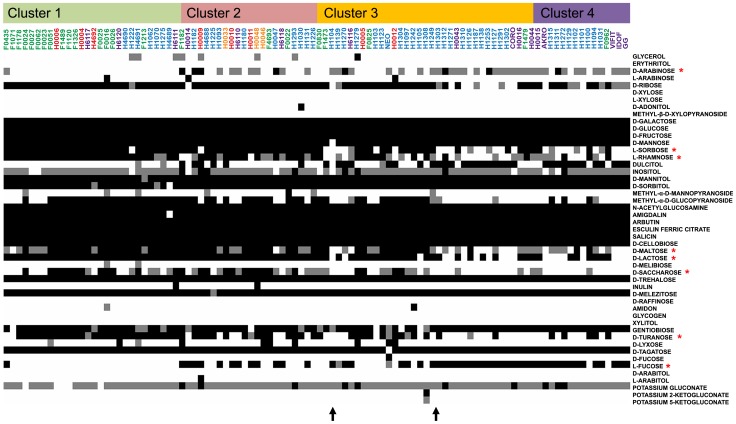
API 50CH fermentative profile of L. rhamnosus strains.Fermentation ability is indicated in black for positive, grey for partially positive and white for negative. Strains are organized according to their genetic relatedness as defined in the hierarchical clustering and coloured according to their respective niche/origin (Figure 1). Carbohydrates of interest are marked by a red asterisk. Black arrows show fermentative profile shifts among L. rhamnosus strains.